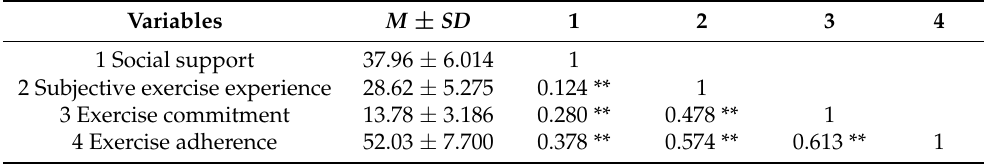
Table 2. Correlation analysis for each variable.